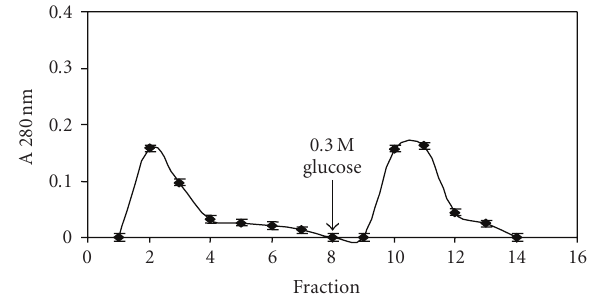
Table 1: Hemagglutinating activity inhibition of Cramoll